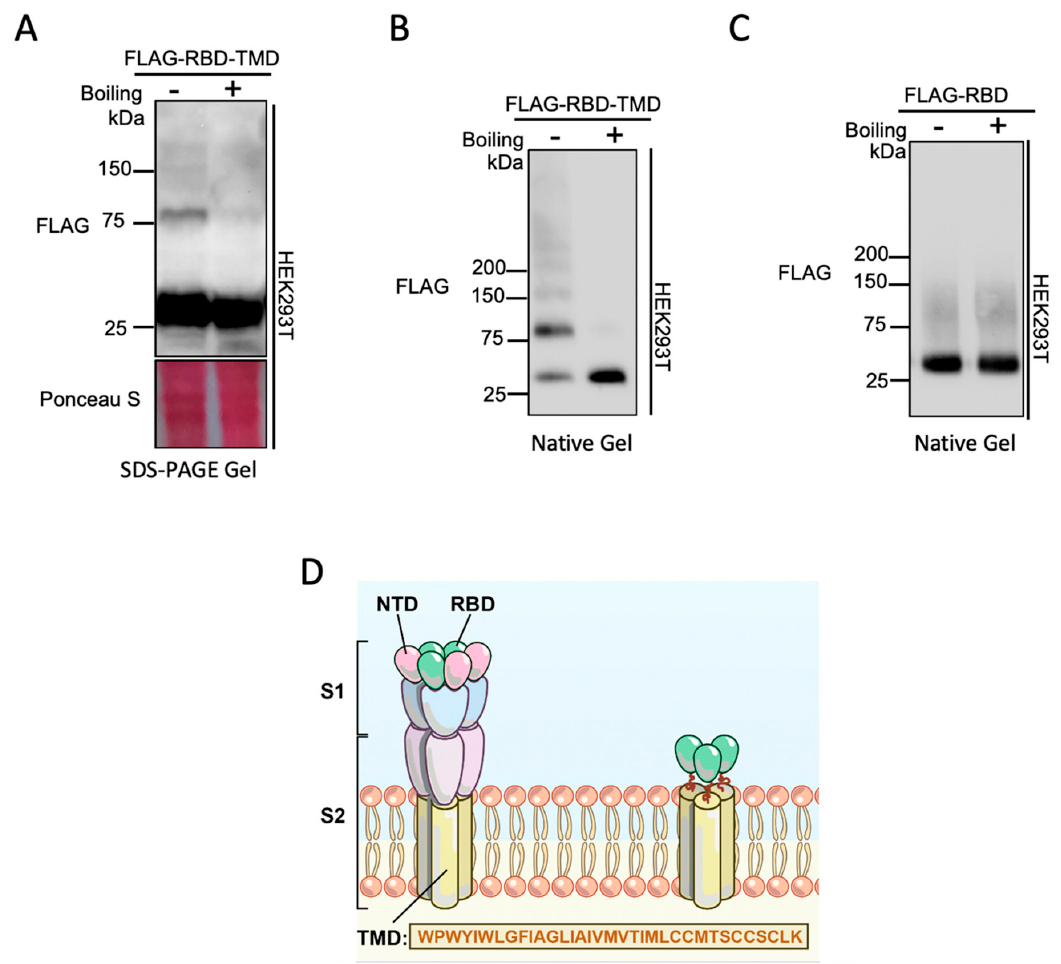
Figure 2. Characterizing the role of the transmembrane domain in the trimerization of the receptor-binding domain. ( A ) SDS-PAGE immunoblot analysis of chimeric RBD with or without boiling the lysate prior to loading. Expected size of RBD is 25kDa. ( B ) Native-PAGE immunoblot of RBD alone with or without boiling the lysate prior to loading. ( C ) Native-PAGE gel analysis of chimeric RBD in the absence or presence of boiling sample prior to loading. ( D ) Schematic of SARS-CoV-2 spike glycoprotein and the chimeric RBD linked to S-TMD. N-terminal domain (NTD); receptor-binding domain (RBD); transmembrane domain (TMD).